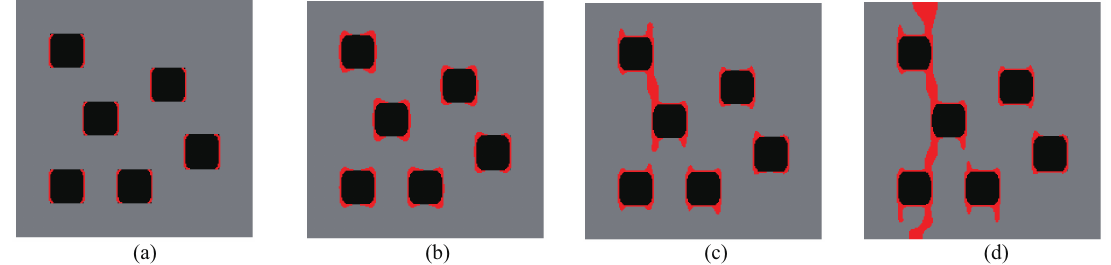
Figure 15. Crack propagation in the initial composite with randomly distributed inclusions subjected to loading case 1: ( a ) ¯ U = 0.03 mm; ( b ) ¯ U = 0.05 mm; ( c ) ¯ U = 0.07 mm; ( d ) ¯ U = 0.09 mm.